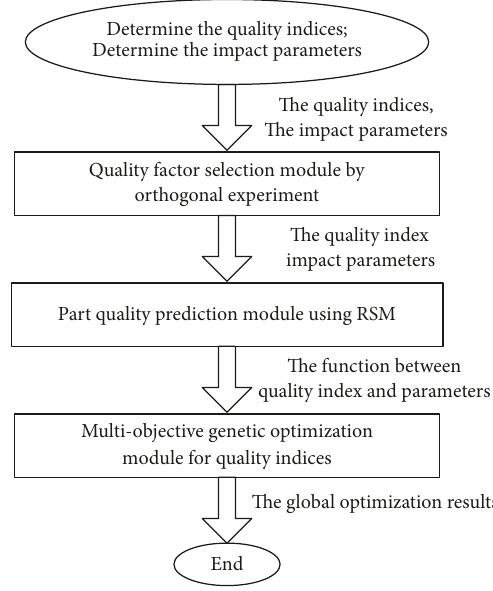
Figure 1: Flowchart of the method.